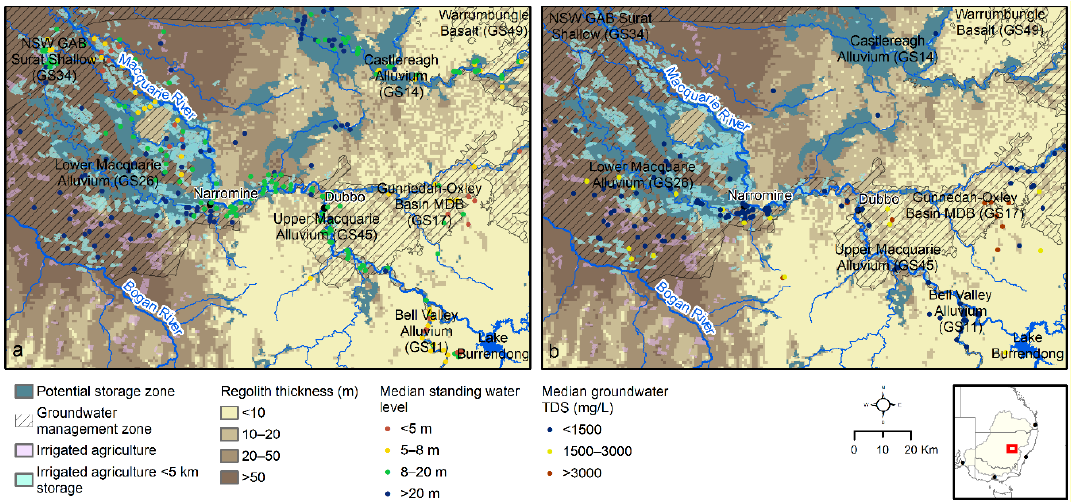
Figure 6. Aquifer storage potential where salinity class is < 1500 mg / L in the Macquarie River region below Lake Burrendong: ( a ) overlaid with median standing water levels and ( b ) salinity observations since January 2000.